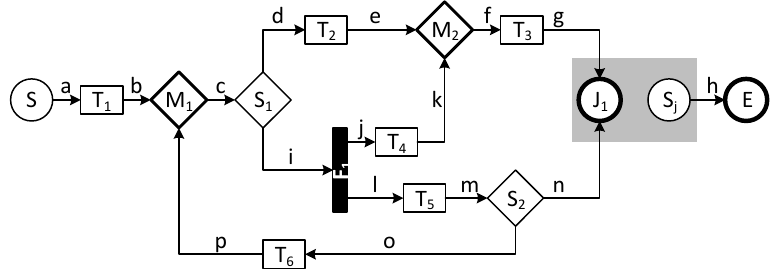
Figure 10. Separation of the join node J